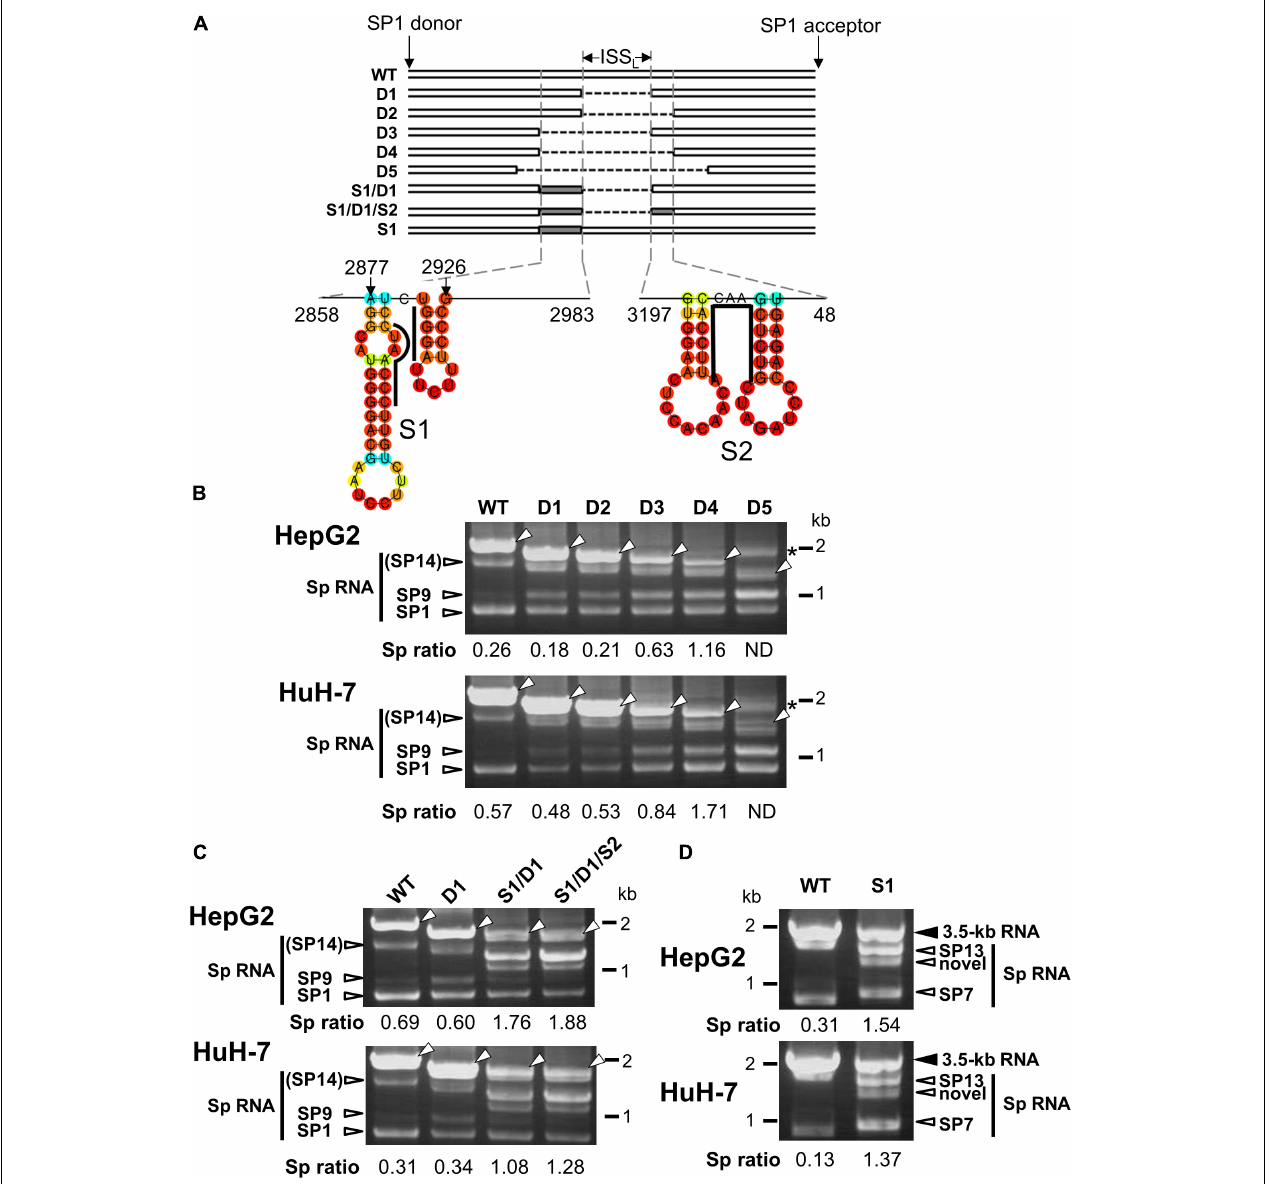
FIGURE 3 | Characterization of the intronic sequence important for silencing of the 3.5 kb RNA splicing. (A) A schematic representation of mutated HBV genomes derived from GT-C with deletions and/or substitutions within the major intron region is shown. Putative secondary structures predicted by the CentroidFold (http://rtools.cbrc.jp/centroidfold/) in nt 2858–2983 and 3197-48 regions are indicated. Each predicted base pair is colored with the heat color gradation from blue to red corresponding to the base-pairing probability. Bold lines are drawn along the sequences targeting to introduce substitution mutations S1 and S2. (B) RT-PCR analysis of HBV RNAs expressed from WT and a series of deletion-mutated HBV genomes (D1–D5) in HepG2 and HuH-7 cells. The quantity ratio of the spliced RNAs to the unspliced RNA (Sp ratio) was determined. ND, not determined. Open arrows, unspliced forms. ∗ cDNA products with aberrant sizes. (C) As described in (B) but HBV mutated genomes S1/D1 and S1/D1/S2 in addition to WT and D1 were used for RNA expression. (D) As in (C) but S1 mutant and WT were expressed in the cells. Bands corresponding to unspliced 3.5 kb RNA and its spliced forms (Sp RNA) were